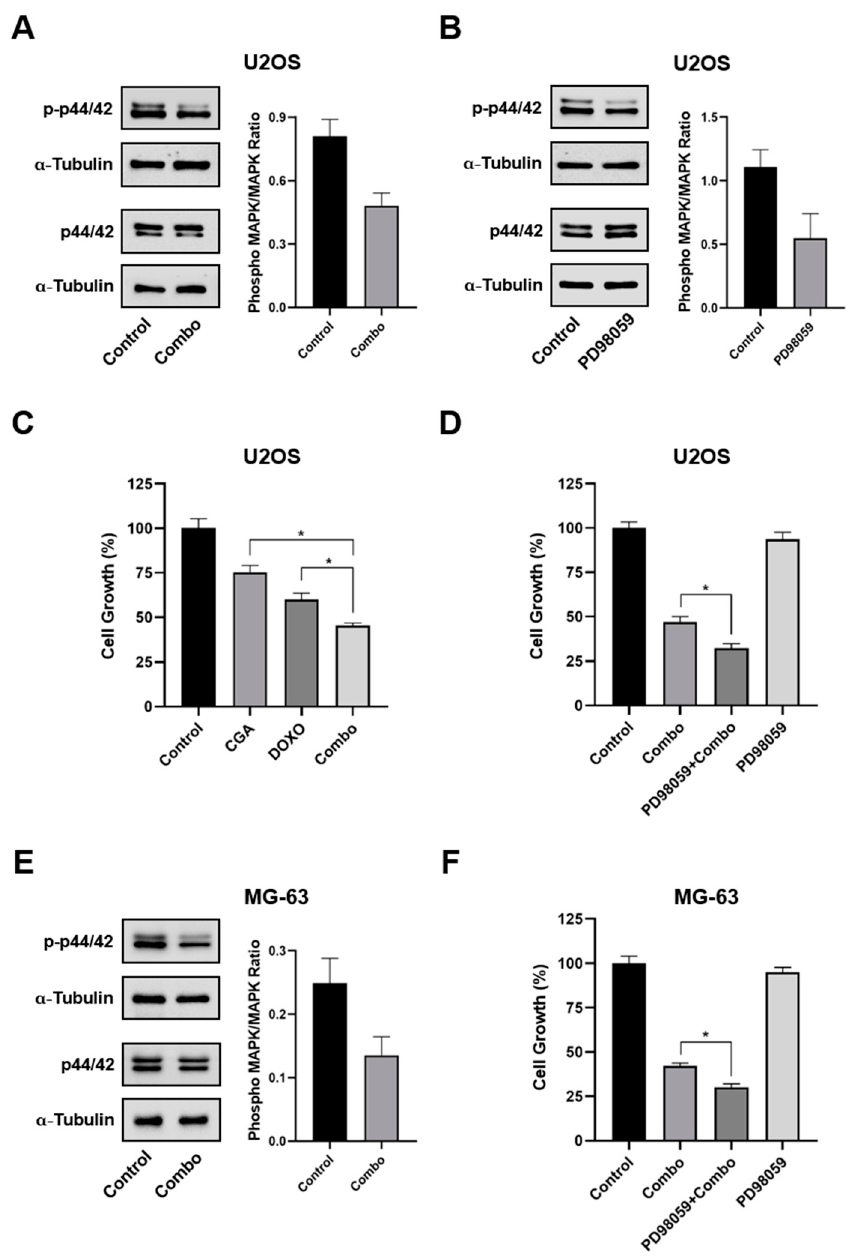
Figure 7. Estimation of MAPK involvement in CGA-mediated Doxo sensitization. U2OS ( A ) and MG-63 ( E ) were treated and not (control) with 300 µM CGA plus 0.2 µM Doxo (combo) for 24 h, and then the relative impact on p44/42 MAPK was assessed by Western blotting. ( B ) Analysis of total and phosphorylated p44/42 MAPK levels following 24 h of exposure to 10 µM PD98059. ( C ) U2OS were treated and not (control) with 300 µM CGA, 0.2 µM Doxo, and CGA plus Doxo (combo) for 24 h, and then the relative cell number in percentage of control was estimated. Combination treatment impact on U2OS ( D ) and MG-63 ( F ) cell growth in an MAPK proficient and hampered background. Three hours pre-treatment with 10 µM of PD98059 preceded and not combo administration. * p < 0.05 by an unpaired two-tailed t -test. Experiments showed in the figure are the end-result of three distinct biological replicates.